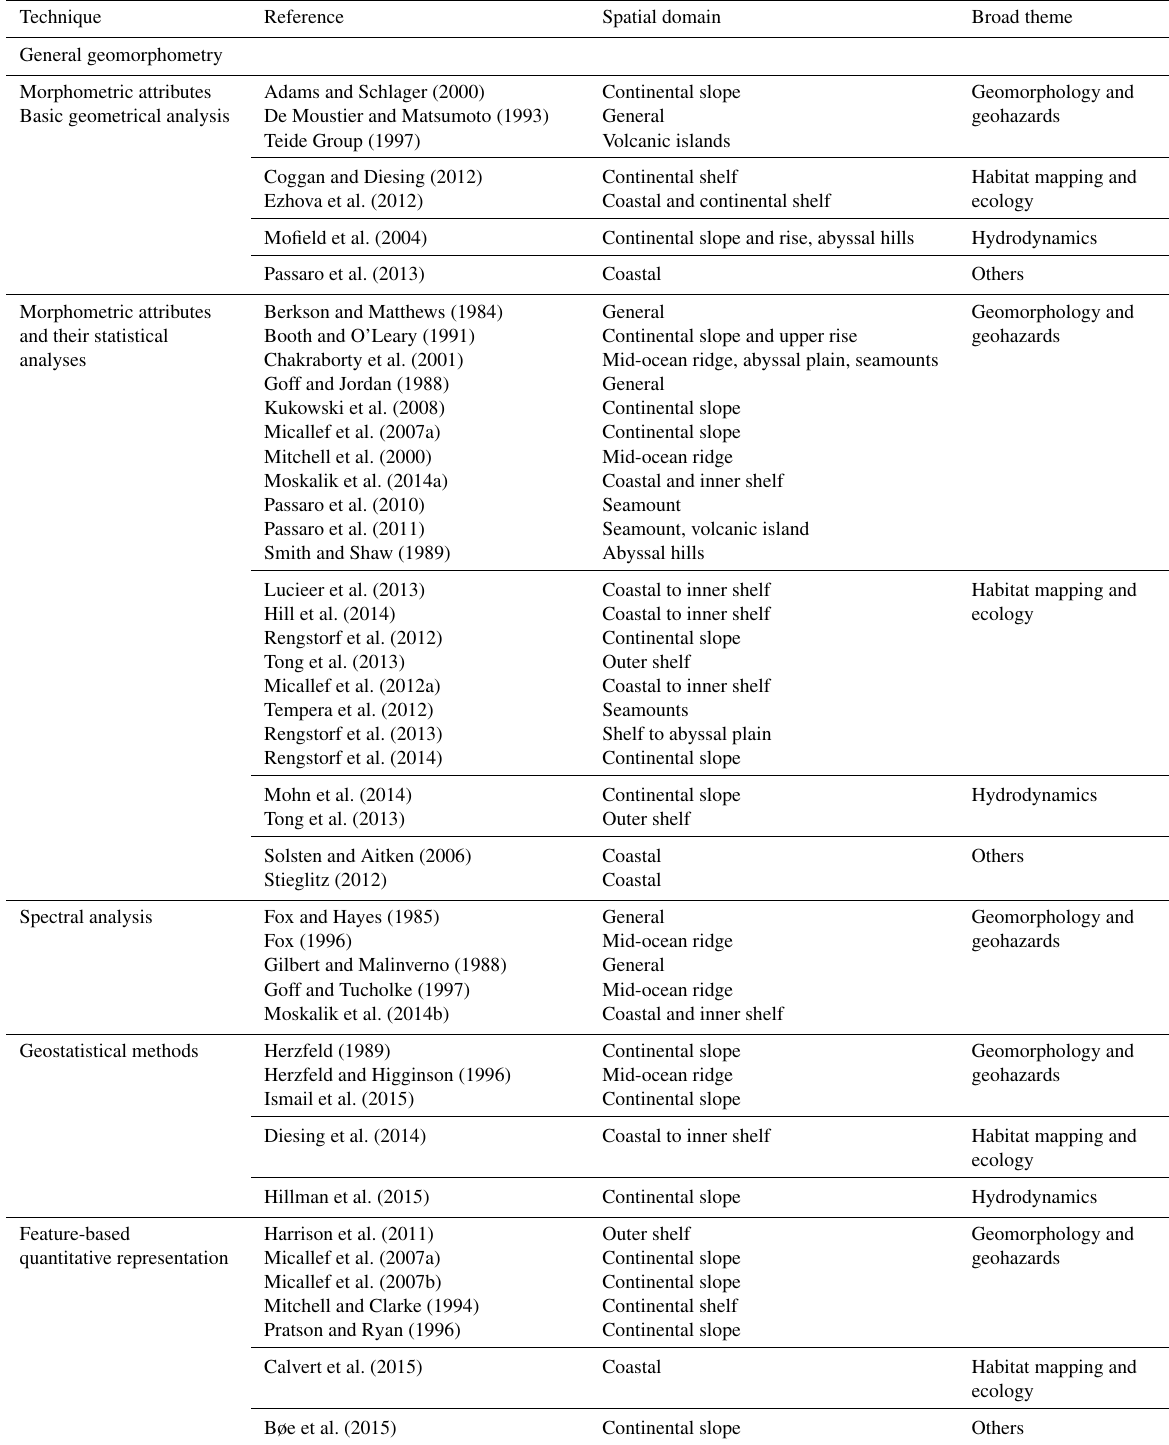
Table 2. Selection of studies published in the last 3 decades that applied geomorphometric techniques to the marine environment. A particular focus is given to marine geomorphology studies, as a few other documents (e.g. McArthur et al., 2010; Brown et al., 2011; Harris and Baker, 2012; Rengstorf et al., 2012; Lecours et al., 2015b) already summarized the extent to which many of these techniques have been employed in habitat mapping studies, and many of these techniques have yet to be employed in other